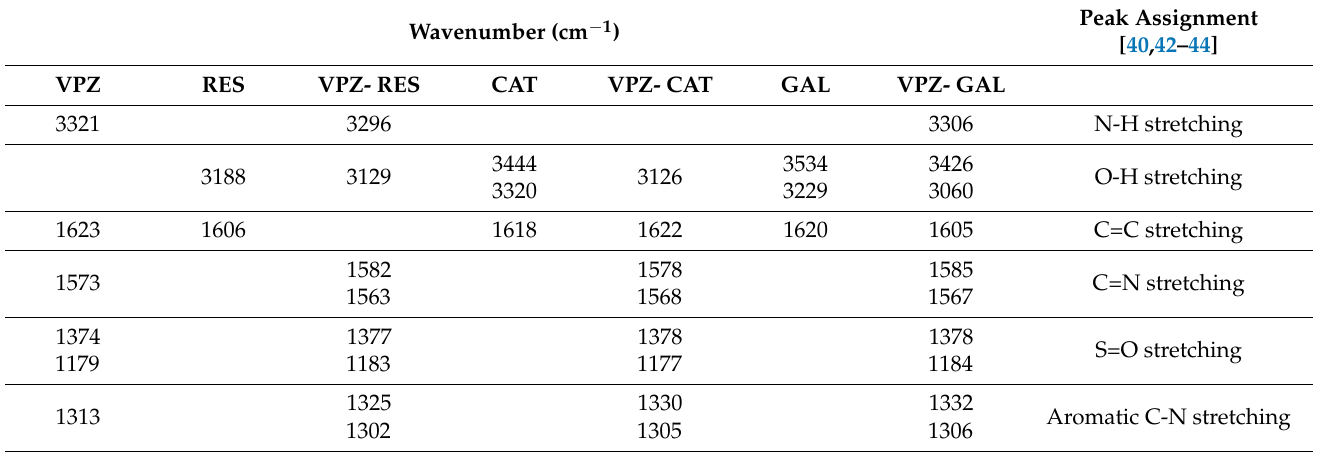
Table 2. Infrared characteristics of VPZ, coformers, and associated